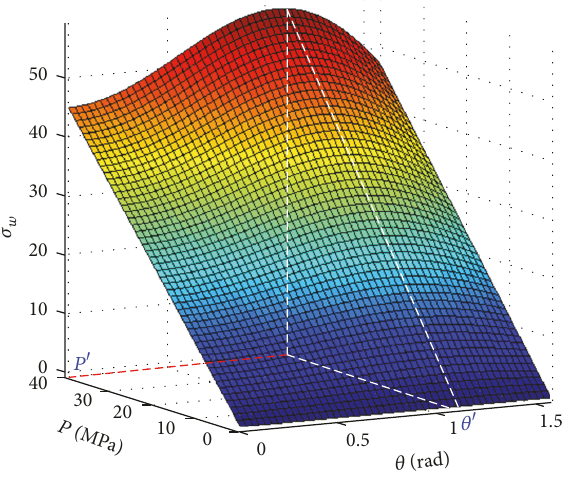
Figure 3: Stress produced by water